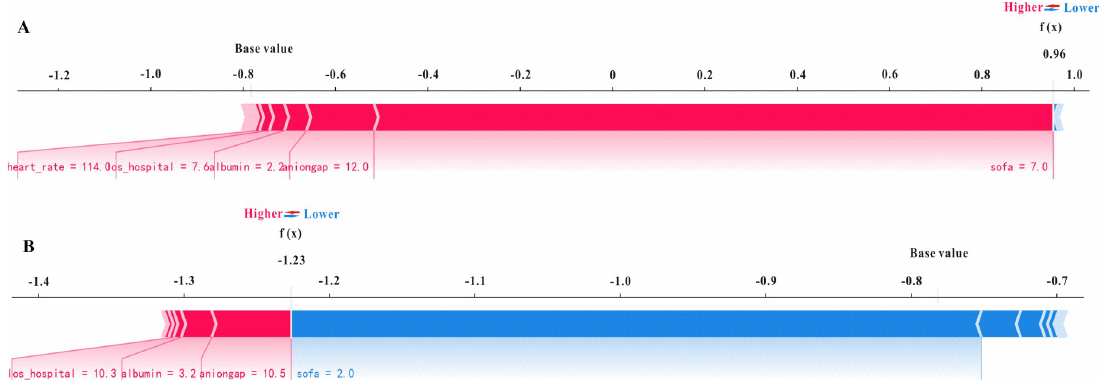
Fig 5. The SHAP force plots. The two representative SHAP force plots of a ( A ) dead and ( B ) survival patient. SHAP force plots are effective in interpreting the prediction value of the model in critical instances. The contribution of each feature to the output predicted value is shown with arrows with their force associated with the shapley values. Red arrows indicate features increasing the prediction results (i.e., yield values) to reach the predicted value (output value). Blue arrows show features decreasing the prediction values to reach the same output value. The arrows with positive and negative effects on yield values compensate on a point which is the prediction (output) value.